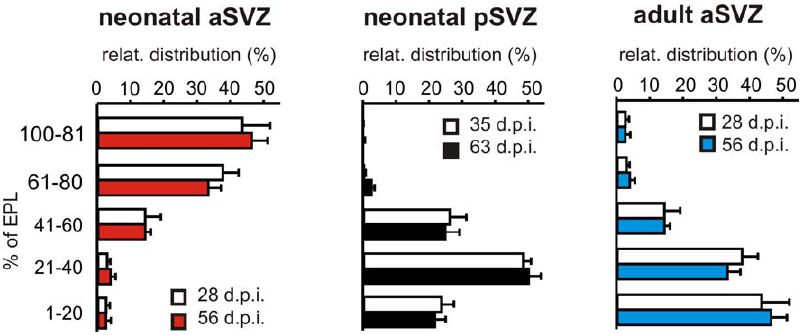
Figure 3. GC Spines in the EPL Were Confined to a Specific Lamina The relative distribution of spines for GCs generated in newborn animals (that were reconstructed in Figure 2.) is plotted at different time points (in d.p.i.). Precursors in neonatal animals from the aSVZ gave rise to GCs with spines confined to the superficial lamina of the EPL, whereas those from the neonatal pSVZ and adult aSVZ gave rise to GCs with spines in the deep lamina.